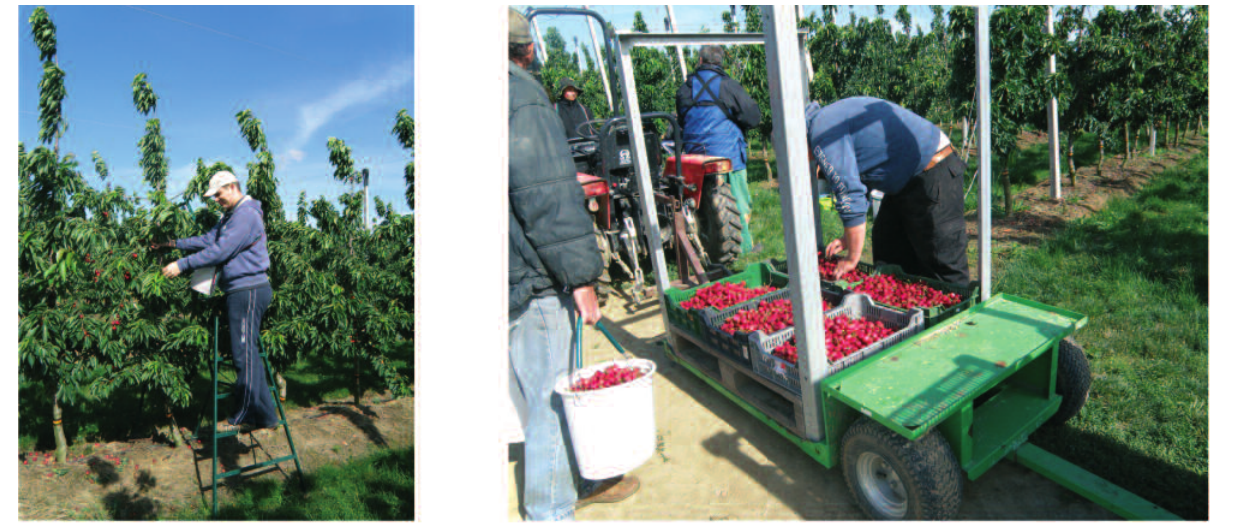
Fig. 1: Manual method of harvesting Fig. 2 : The controlled takeover of the cherry and collection in